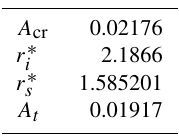
Table 3. Burgers vortex non-dimensional